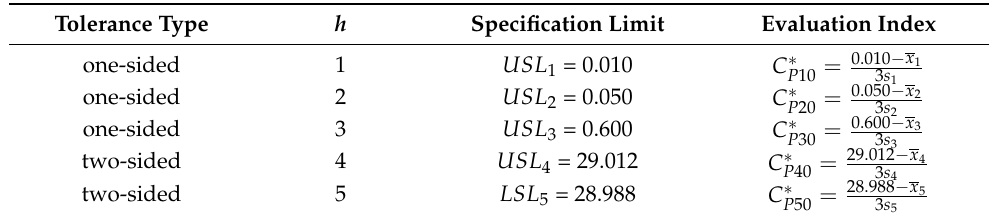
Table 2. Important quality characteristics and corresponding evaluation index values after the gear inner hole grinding.